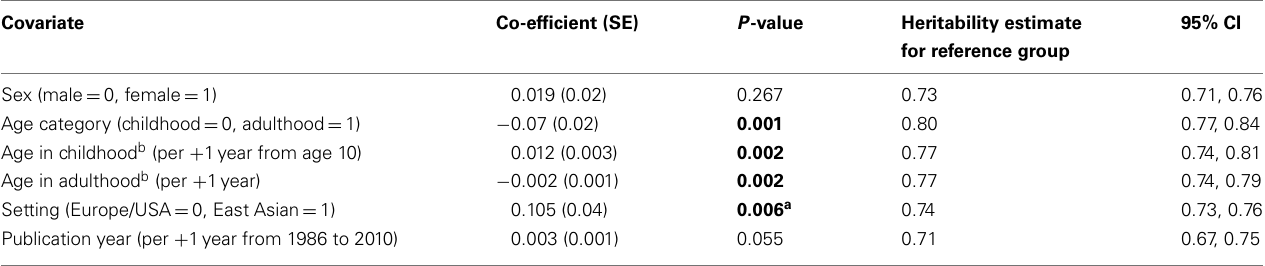
Table 2 | Results of meta-regression analyses to identify study-level demographic factors associated with reported BMI heritability estimates in twin studies.